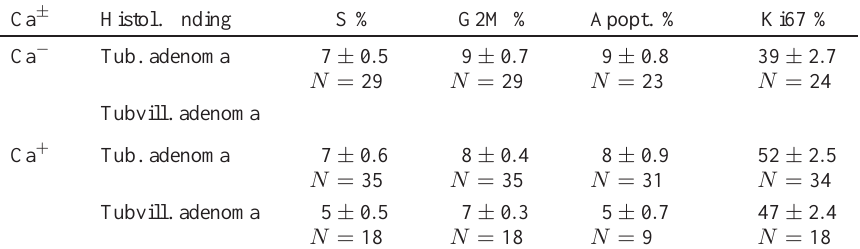
Table 3 Cell cycle distribution, subdiploid apoptotic fraction and Ki67 positive cells in DNA